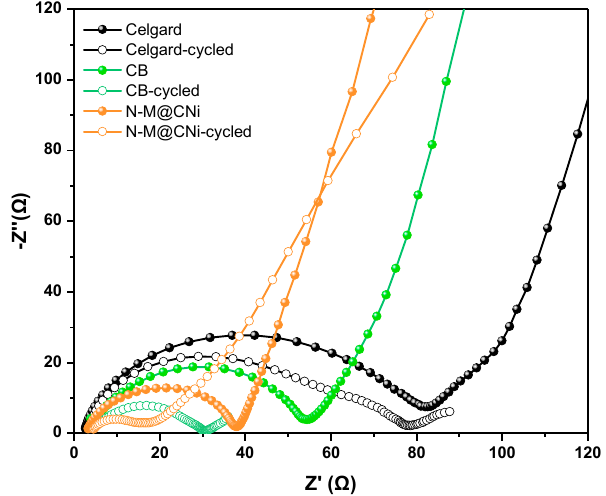
Figure 7. The EIS plots of Celgard, CB, and N-M@CNi cells before (solid dots) and after 10 cycles (hollow dots) at 0.2 C.